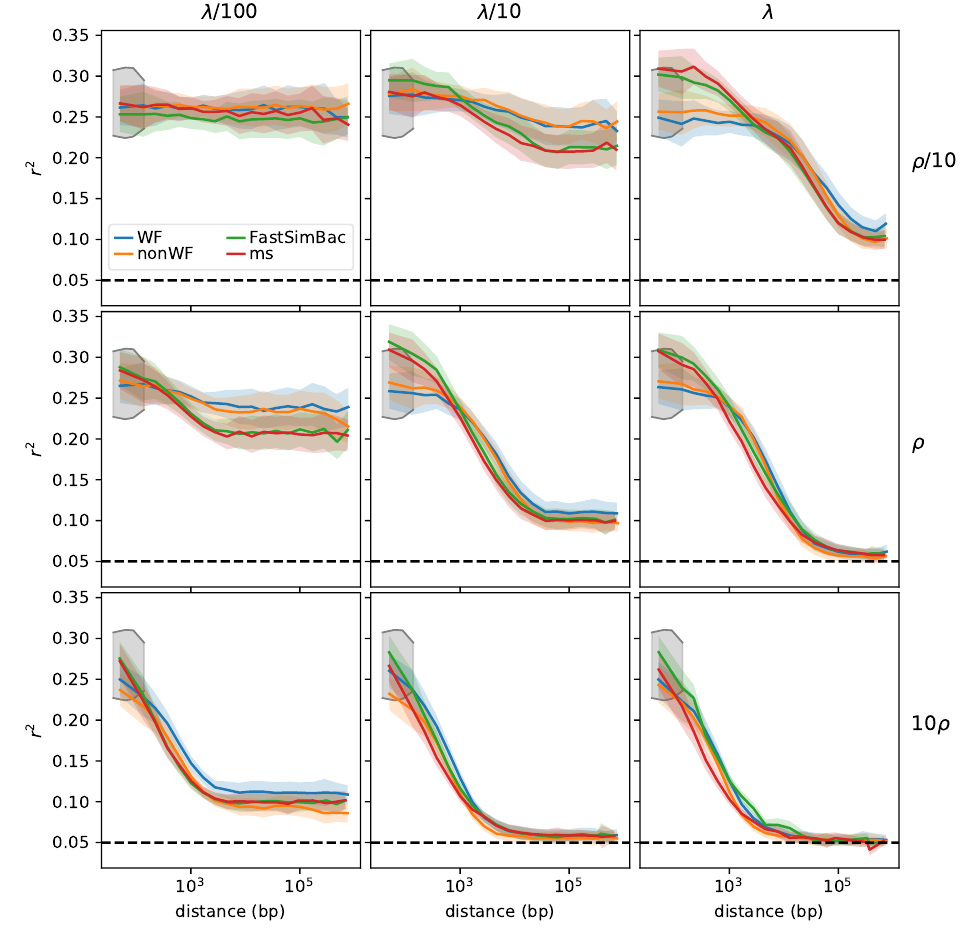
Figure 6 – Linkage disequilibrium for WF and nonWF simulations with various recom- bination rates ( ρ ) and tract lengths ( λ ). The colored shaded areas represent standard error of the mean, and the gray area represents the range of expected values at very 2 short distances. The horizontal black dashed line is the expected r with free recombi- nation when sampling 20 individuals (1/20). Parameters used: chromosome size = 2Mb; 10 − 9 ; λ = 122 kb ; Ne = 140k; 30000 generations; RF=25. Various re- µ = ρ = 1 . 53 × combination rates and mean tract lengths produce similar patterns of LD between SLiM simulations and backward